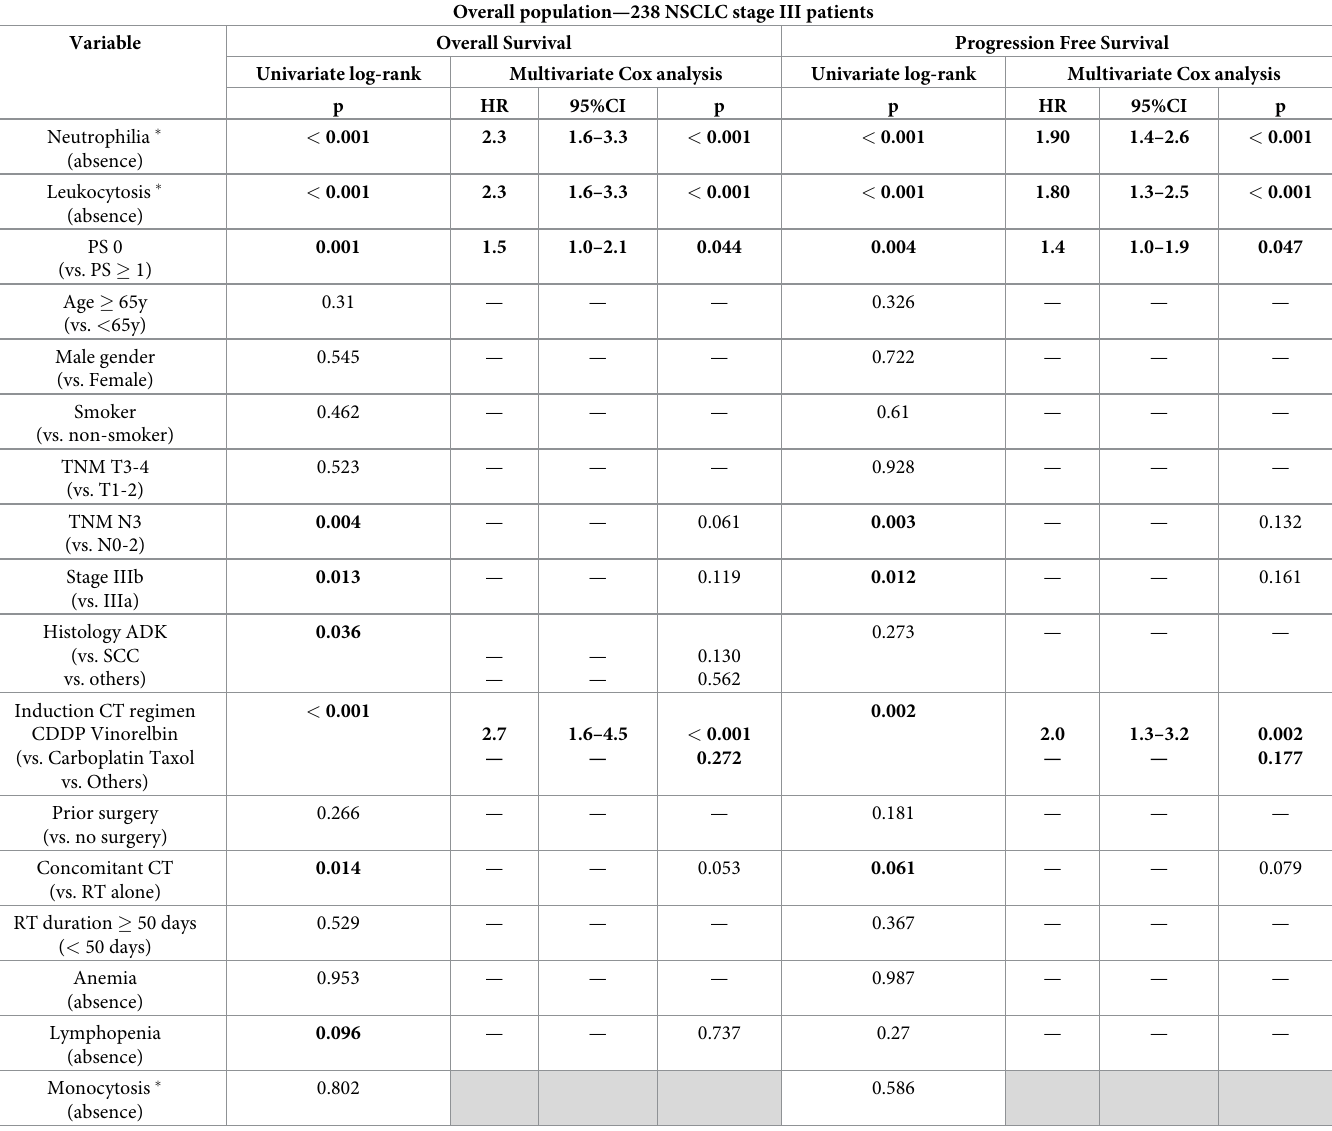
Table 2. Results of univariate and multivariate (Cox) analyses for overall survival and progression free survival (significant factors in bold). Overall population—238 NSCLC stage III